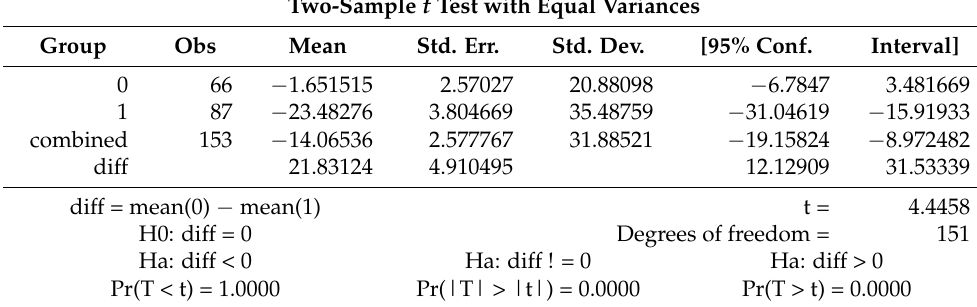
Table 7. Mean test on revenue by activity